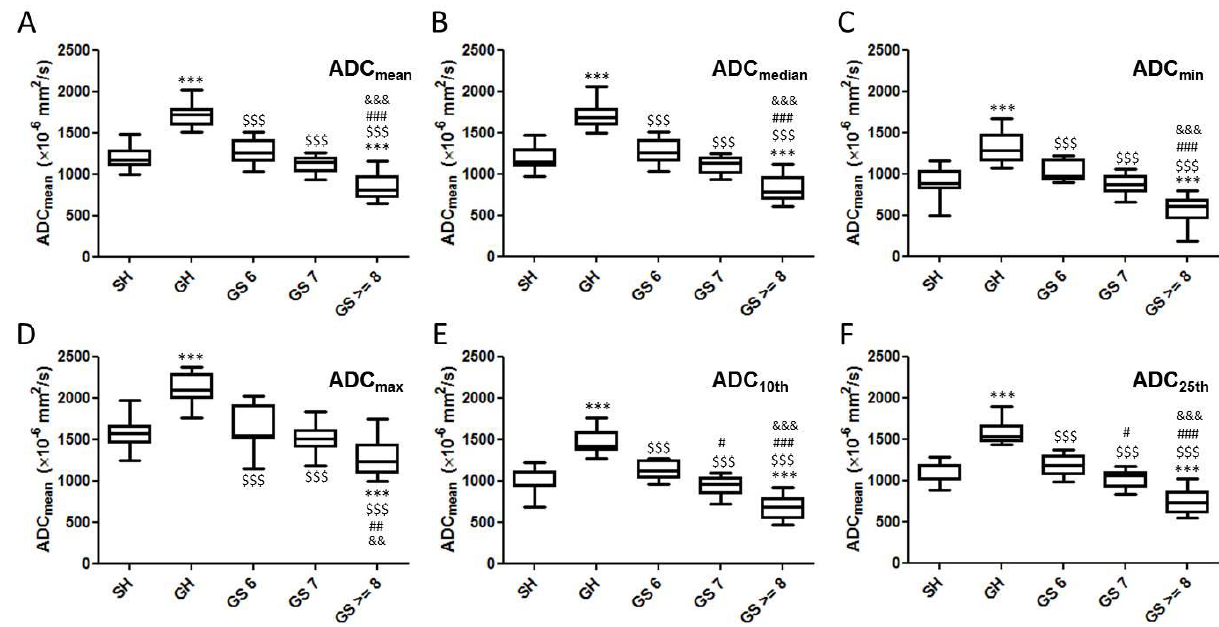
Figure 5. Box plots comparing the six histogram-derived ADC parameters in two BPH groups and the Gleason-graded groups. ( A ) ADC mean ; ( B ) ADC median ; ( C ) ADC min ; ( D ) ADC max ; ( E ) ADC 10th ; ( F )